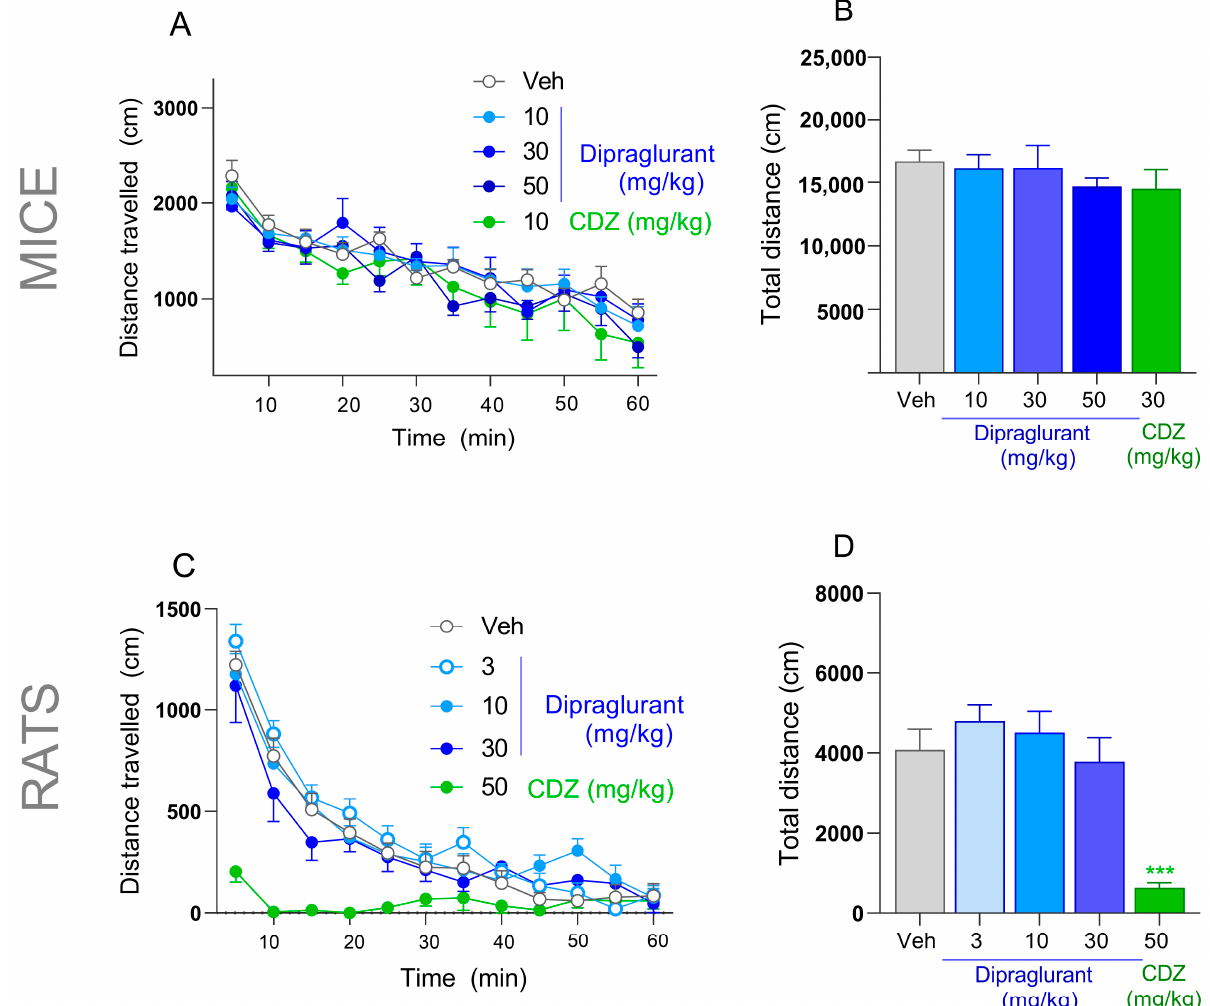
Figure 5. ( A , B ) Locomotor activity of male C57Bl6/J mice ( n = 8/group) and ( C , D ) Sprague-Dawley rats ( n = 8/group) during 60 min, expressed as time-course profiles ( A , C ) or total traveled distances ( B , D ). Mice were treated with either dipraglurant (10, 30, 50 mg/kg p.o.), vehicle (distilled water, p.o.) or chlordiazepoxide (CDZ; 10 mg/kg, i.p.). Rats were treated with either dipraglurant (3, 10, 30 mg/kg p.o.), vehicle (distilled water, p.o.), or CDZ (50 mg/kg, i.p.) Each point represents the observed mean ± SEM, *** p < 0.001 compared to vehicle (Veh).